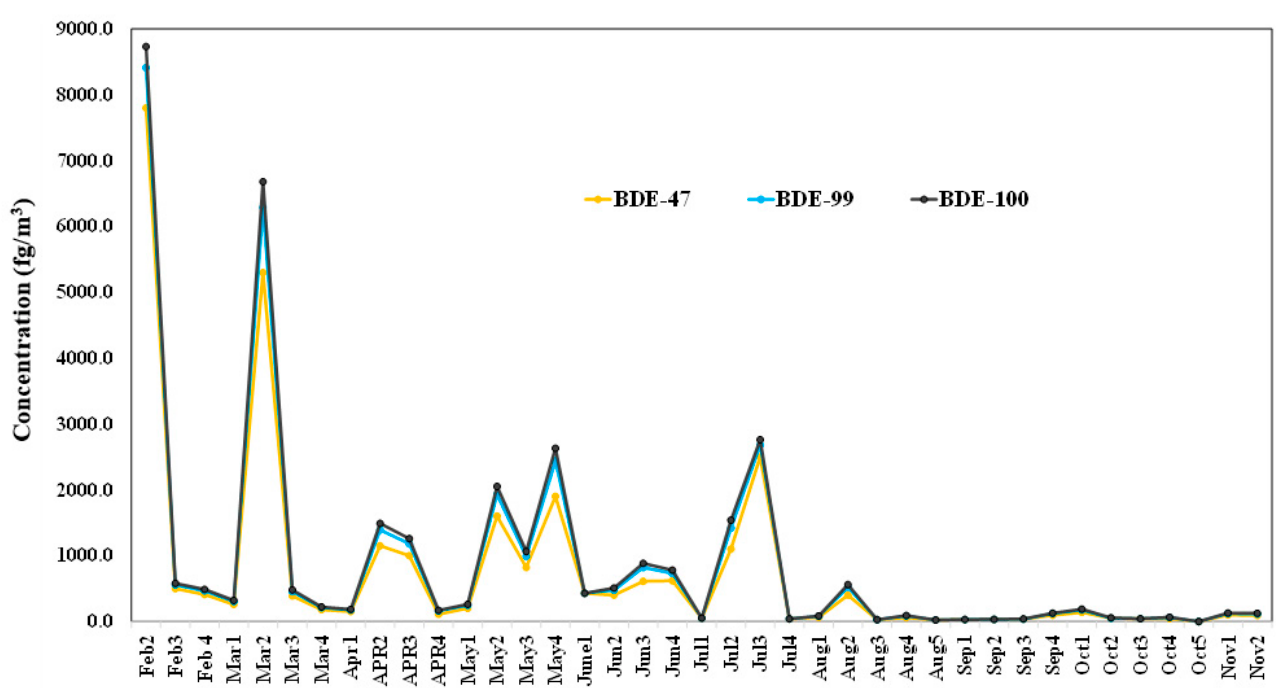
Figure 2. Levels of key penta-formulation congeners detected at Troll station throughout 2013.